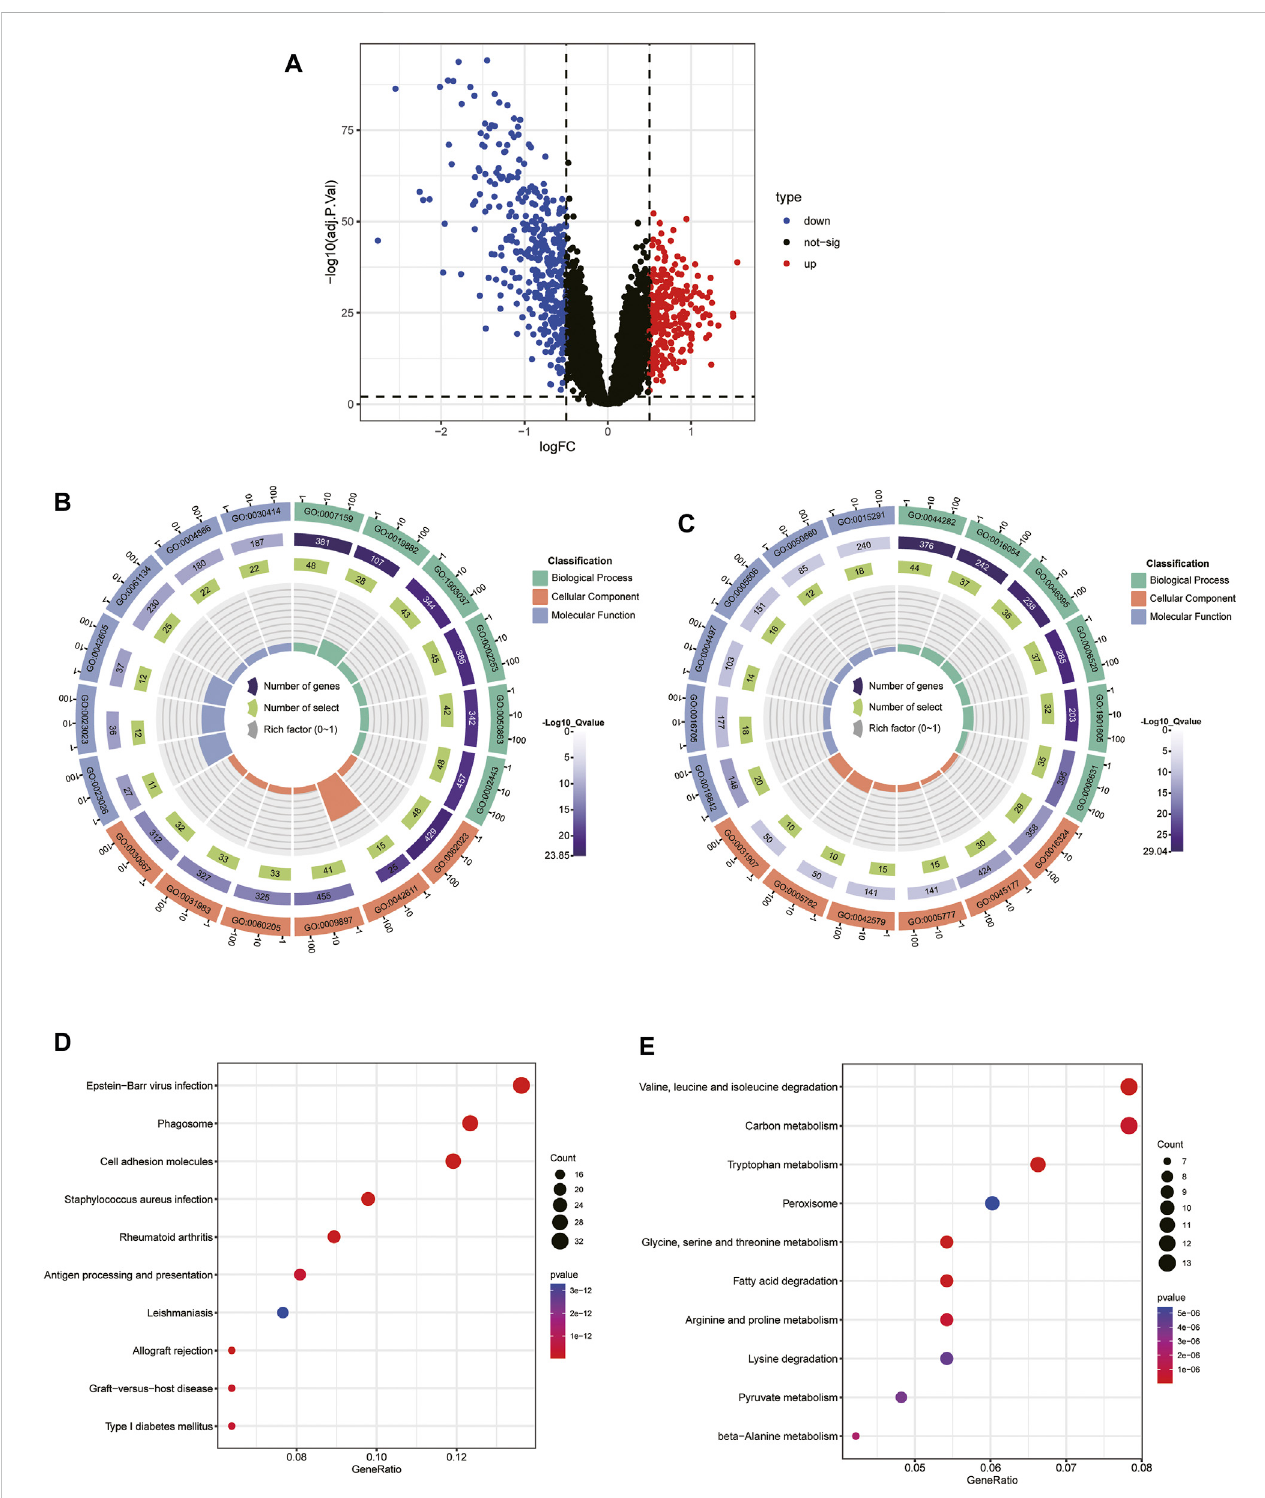
FIGURE 5 Identi fi cationoftheDEGsandenrichmentanalysisbetweenthetwomolecularsubtypes. (A) VolcanoplotoftheDEGsamongclusteroneand2. (B,C) GO analysis of upregulated DEGs in cluster 1 (B) and cluster 2 (C) . (D, E) KEGG analysis of the upregulated DEGs in cluster 1 (D) and cluster 2 (E)